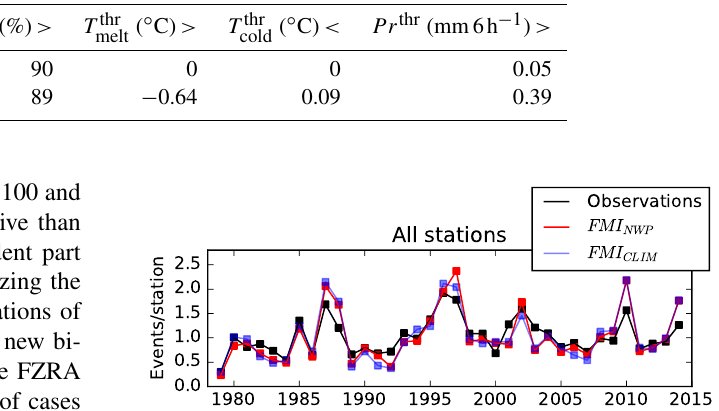
Table 1. Uncalibrated (upper row) and calibrated (bottom), optimal values of threshold parameters in the 29-year calibration periods. Mean values of the optimal values are shown, computed for calibration periods using the sample variance of period values. Mean values are = minimum cold layer depth; RH thr = minimum humidity and minimum used in the final analysis of the gridded data set. h thr and T thr cold melt melt = maximum cold layer temperature; and Pr thr = minimum surface precipitation rate. temperature in the melting layer; T thr cold